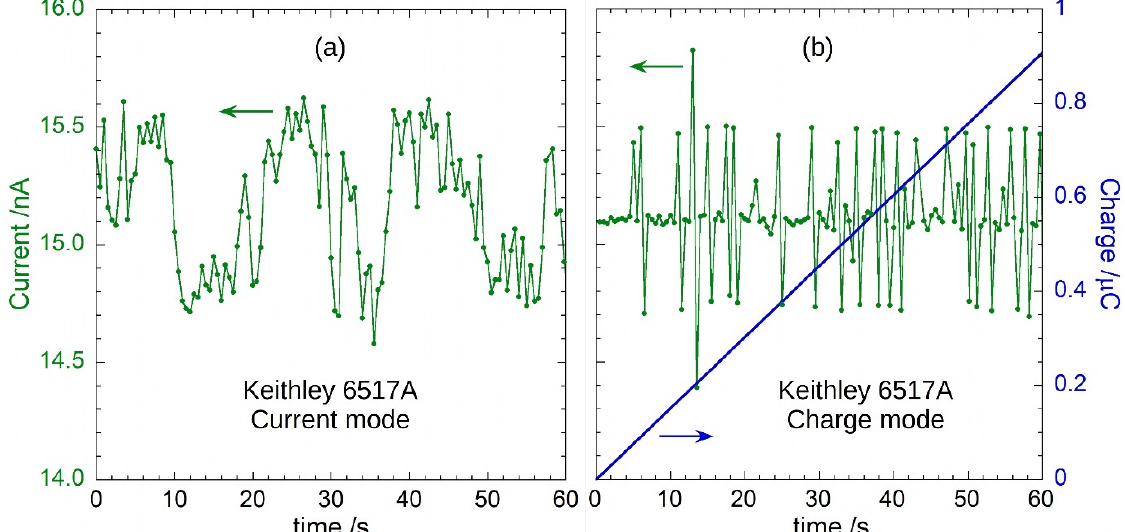
Figure 10. Photogenerated current and collected charge for the diamond dosimeter irradiated by 6 MV pulsed X-rays ( PRF = 180 Hz): ( a ) current (green dots) measured by a Keithley 6517A electrometer; and ( b ) collected charge (blue line) measured by the 6517A electrometer during 1 min of diamond irradiation; green dots are calculated as Δ Q/ Δ T (see text).